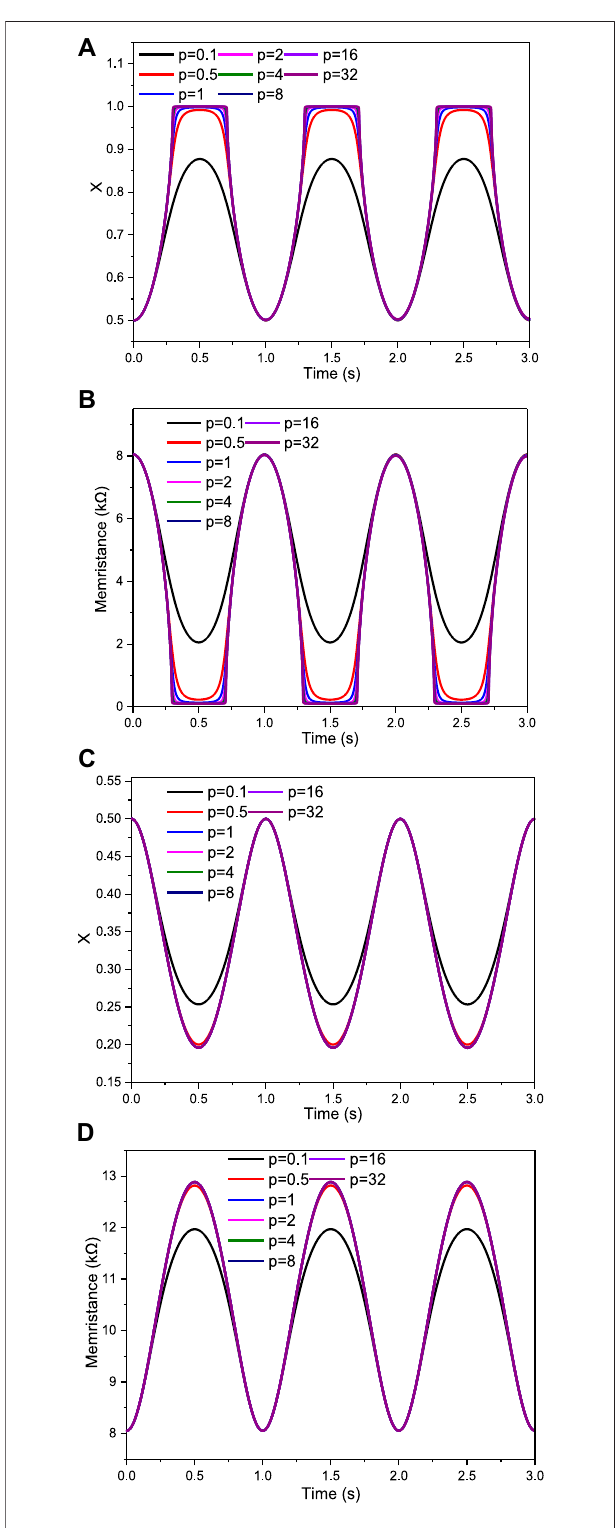
FIGURE 3 | Time dependence of (A) the state variable and (B) memristance with voltage sinusoidal stimulus of v ( t ) (cid:1) sin ( 2 π t ) , and (C) the state variable and (D) memristance with voltage sinusoidal stimulus of v ( t ) (cid:1) − sin ( 2 π t ) for various p